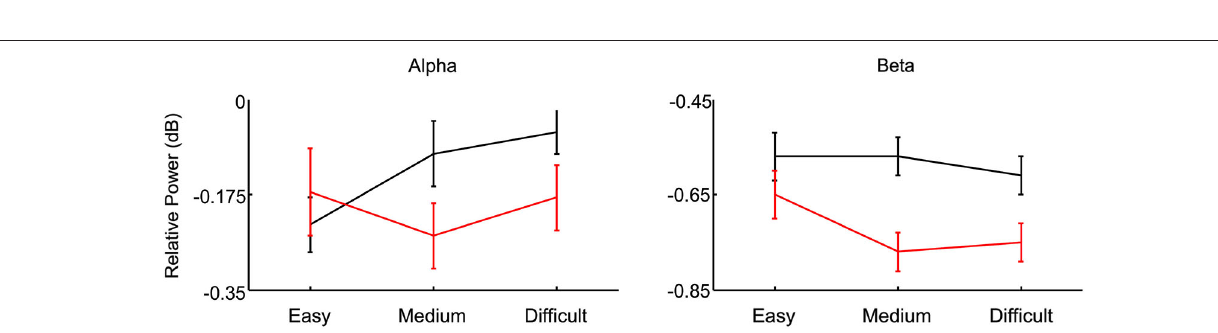
stop trials were slower compared with no-stop trials that preceded wrong stop trials (L: p = 0.002; S: p = 0.006). The same result was observed for no-stop trials that followed correct stop